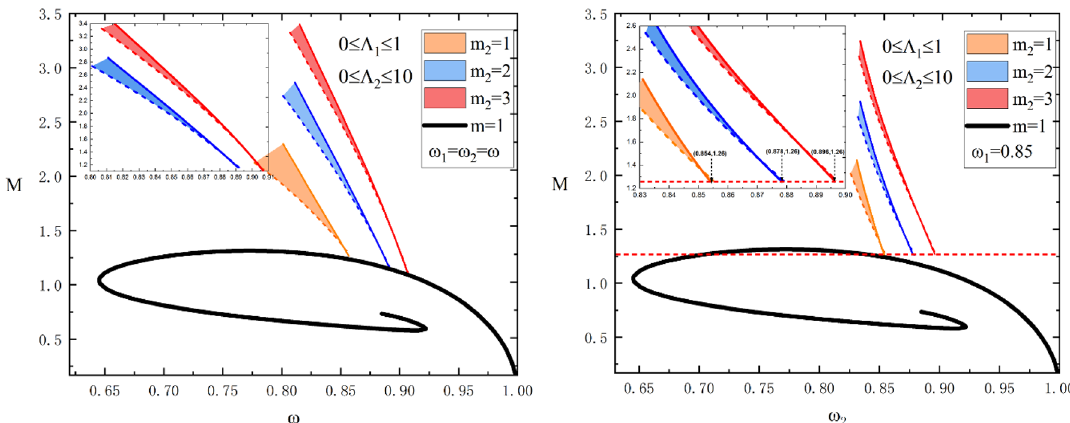
Figure 5 . Left : the mass M of the SIMBSs as a function of the synchronized frequency ω with the azimuthal harmonic indexes m 2 = 1 , 2 , 3 . Right : the mass M of the SIMBSs as a function of the nonsynchronized frequency ω 2 with ω 1 = 0 . 85 . The horizon red dashed line indicates the mass M = 1 . 26 . In both panels, the shaded regions corresponds to 0 ≤ Λ 1 ≤ 1 and 0 ≤ Λ 2 ≤ 10 . The black spiral curve indicates the ground state with m = 1 and all solutions have µ 1 = 1 , µ 2 = 0 . 93 , m 1 = 1